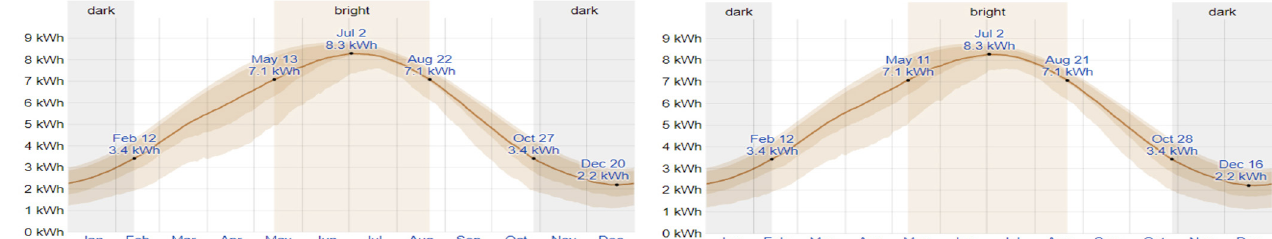
Fig. 2. The average daily shortwave solar energy reaching the ground per square meter in Serpa and Odemira through the year. Image adapted from pt.weatherspark.com.